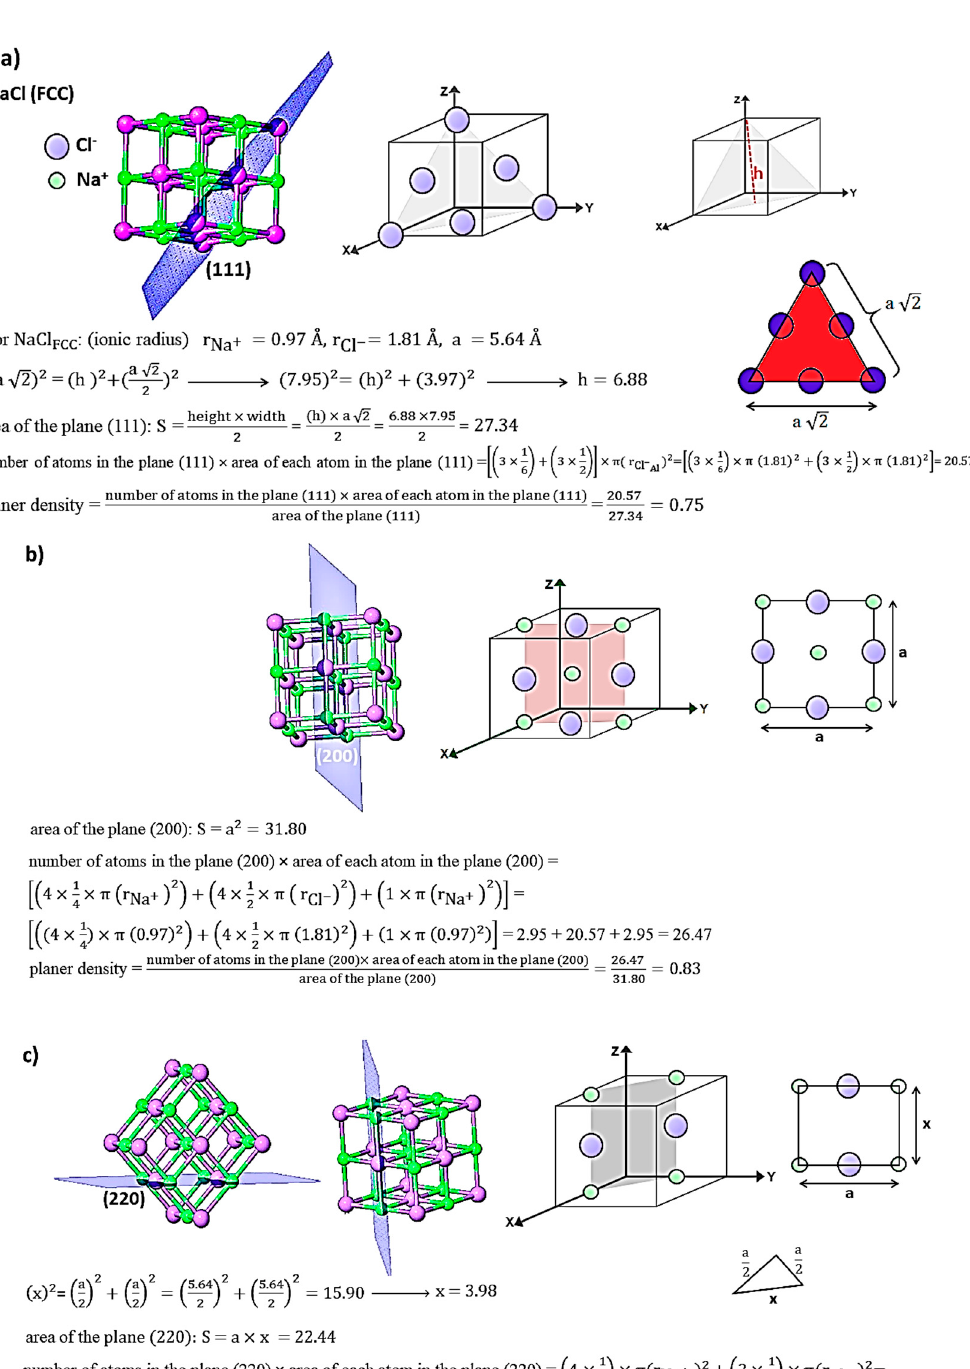
Figure 7. Geometry and the situation of involved atoms in diffracted planes ( a ) (111), ( b ) (200) and ( c )